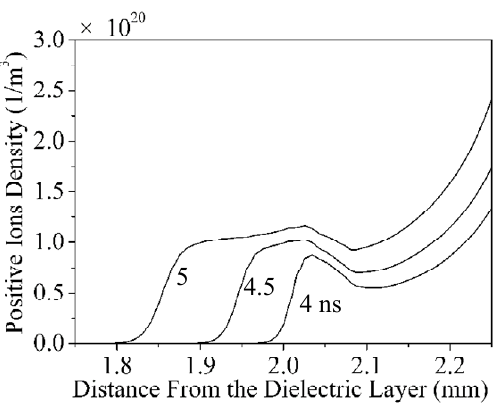
Figure 16. Positive ion density distribution along the axis of symmetry of the SNG.